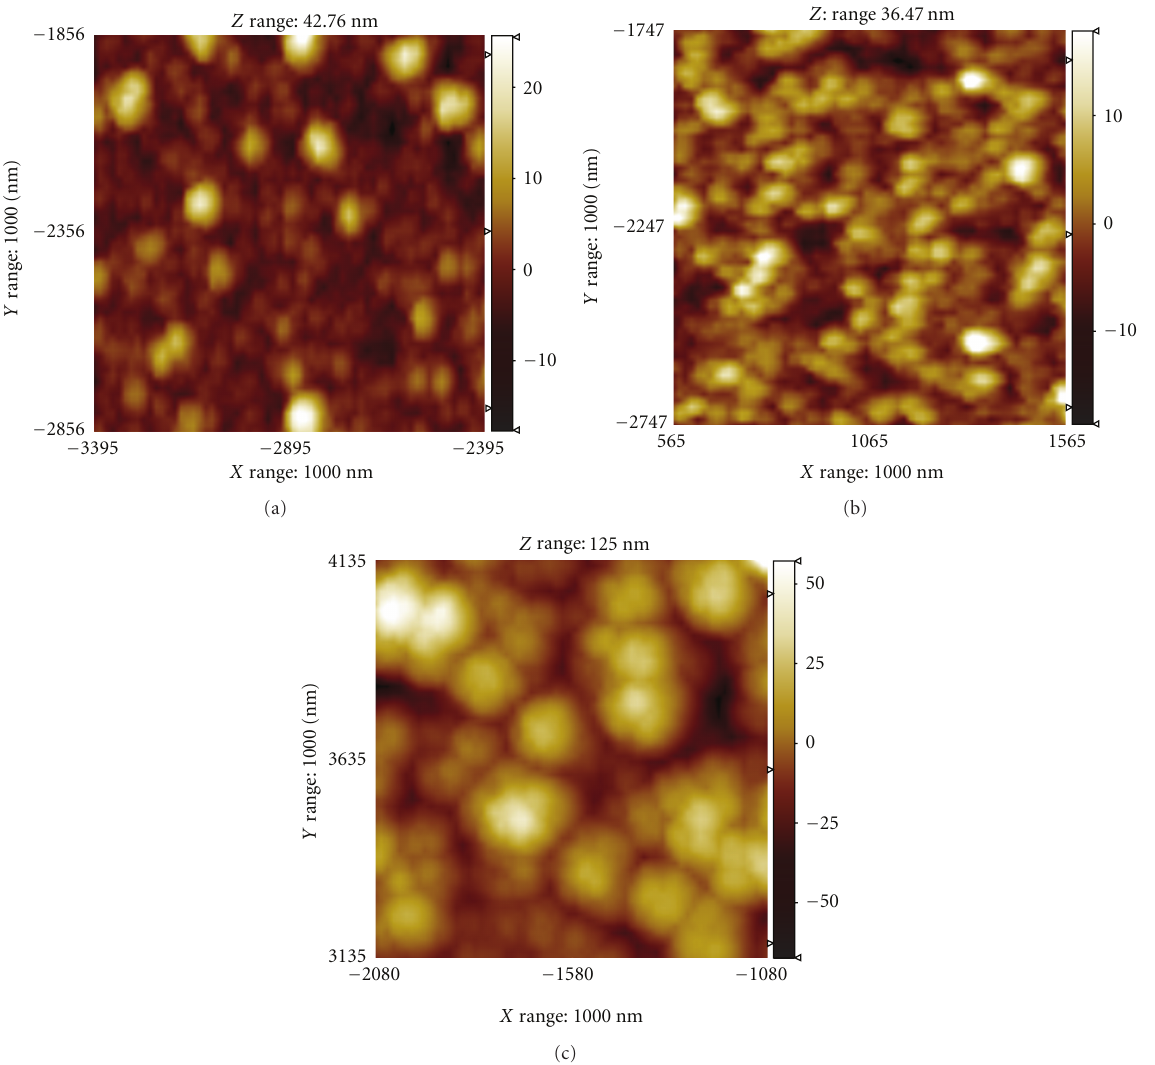
Figure 6: Noncontact atomic force microscopy (NC-AFM) images (topography) of films deposited by hot wire method at various process pressure. (a) P p = 30 mTorr (a-Si:H). (b) P p = 90 mTorr (onset of nanocrystallization). (c) P p = 300 mTorr